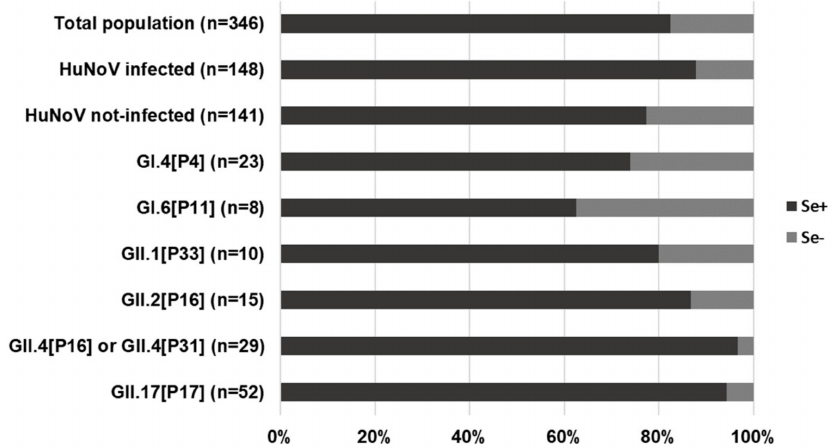
Figure 1. Distribution of secretor and nonsecretor subjects in di ff erent subgroups of studied individuals.